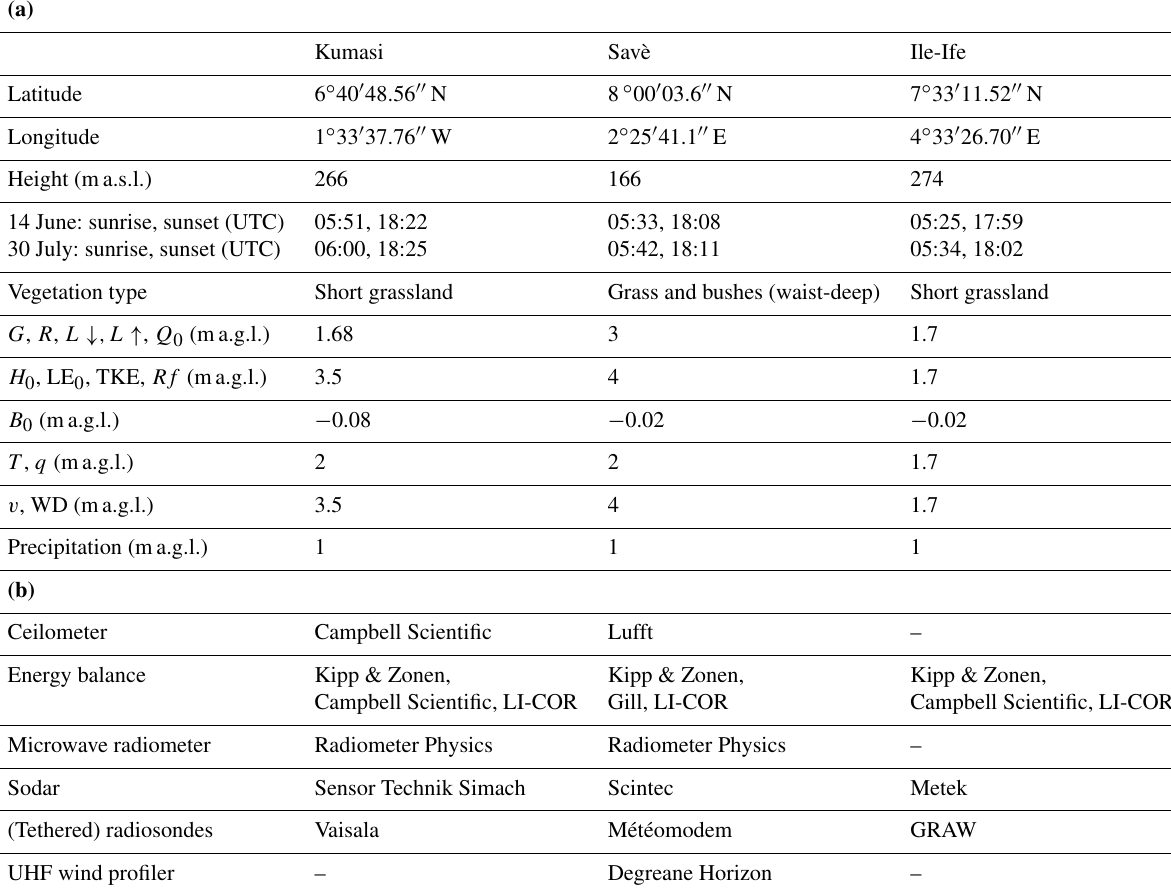
Table 1. (a) Coordinates and station heights in metres above sea level (ma.s.l.) and measurement heights in metres above ground level (ma.g.l.) of the energy balance station instruments at three supersites. Q 0 represents the total net radiation, R the shortwave upward radiation and G the shortwave downward radiation, L ↑ the longwave upward radiation and L ↓ the longwave downward radiation, H 0 the